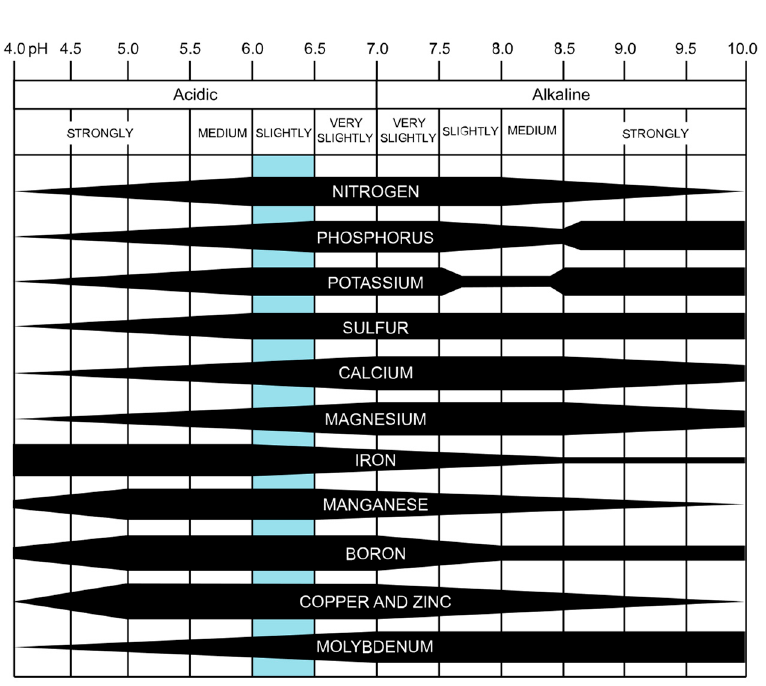
Figure 3. Chart representing availability of soil nutrients in terms of soil pH [110].